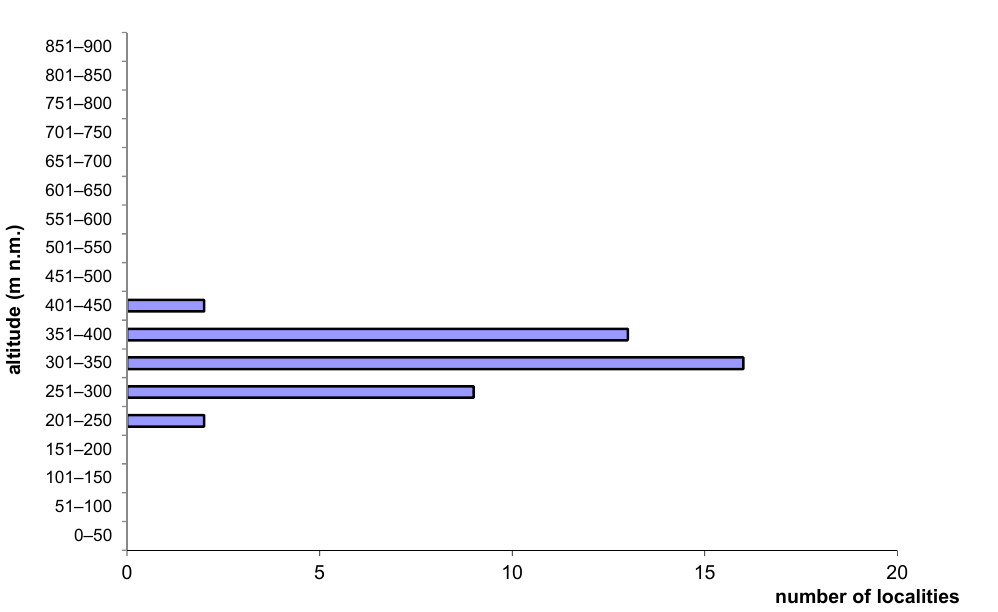
Figure 2. Number of localities with Cordulegaster heros populations in the Czech Republic based on altitude (all authors ( n = 42)).